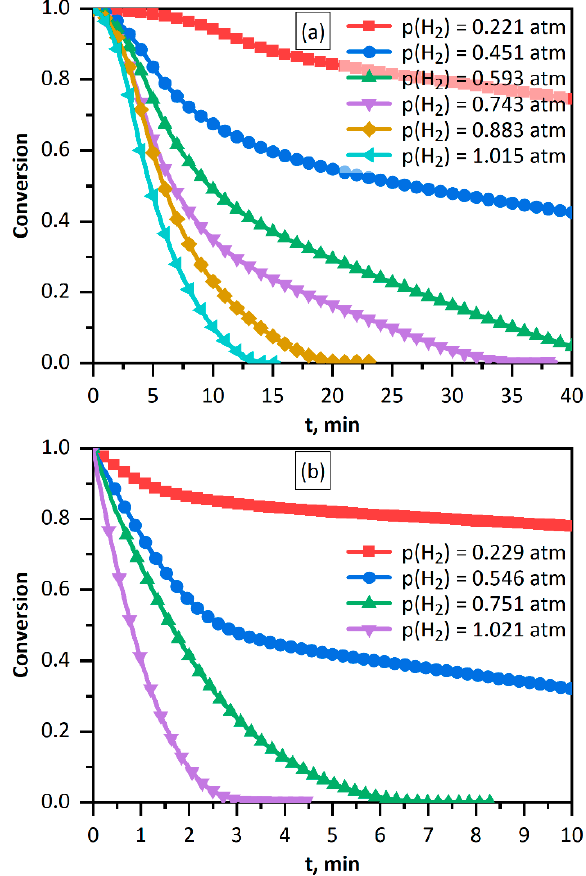
Figure 4. Kinetic curves for Fe(CN) 63 – reduction with hydrogen. Hydrogen pressure above the solutions given in legend. Without ( a ) and with ( b ) preliminary saturation of palladium hydrosol with hydrogen. Solutions: [ Fe(CN) 63 – ] = 1.00 mM, [ Pd 0 ] = 0.020 mM.